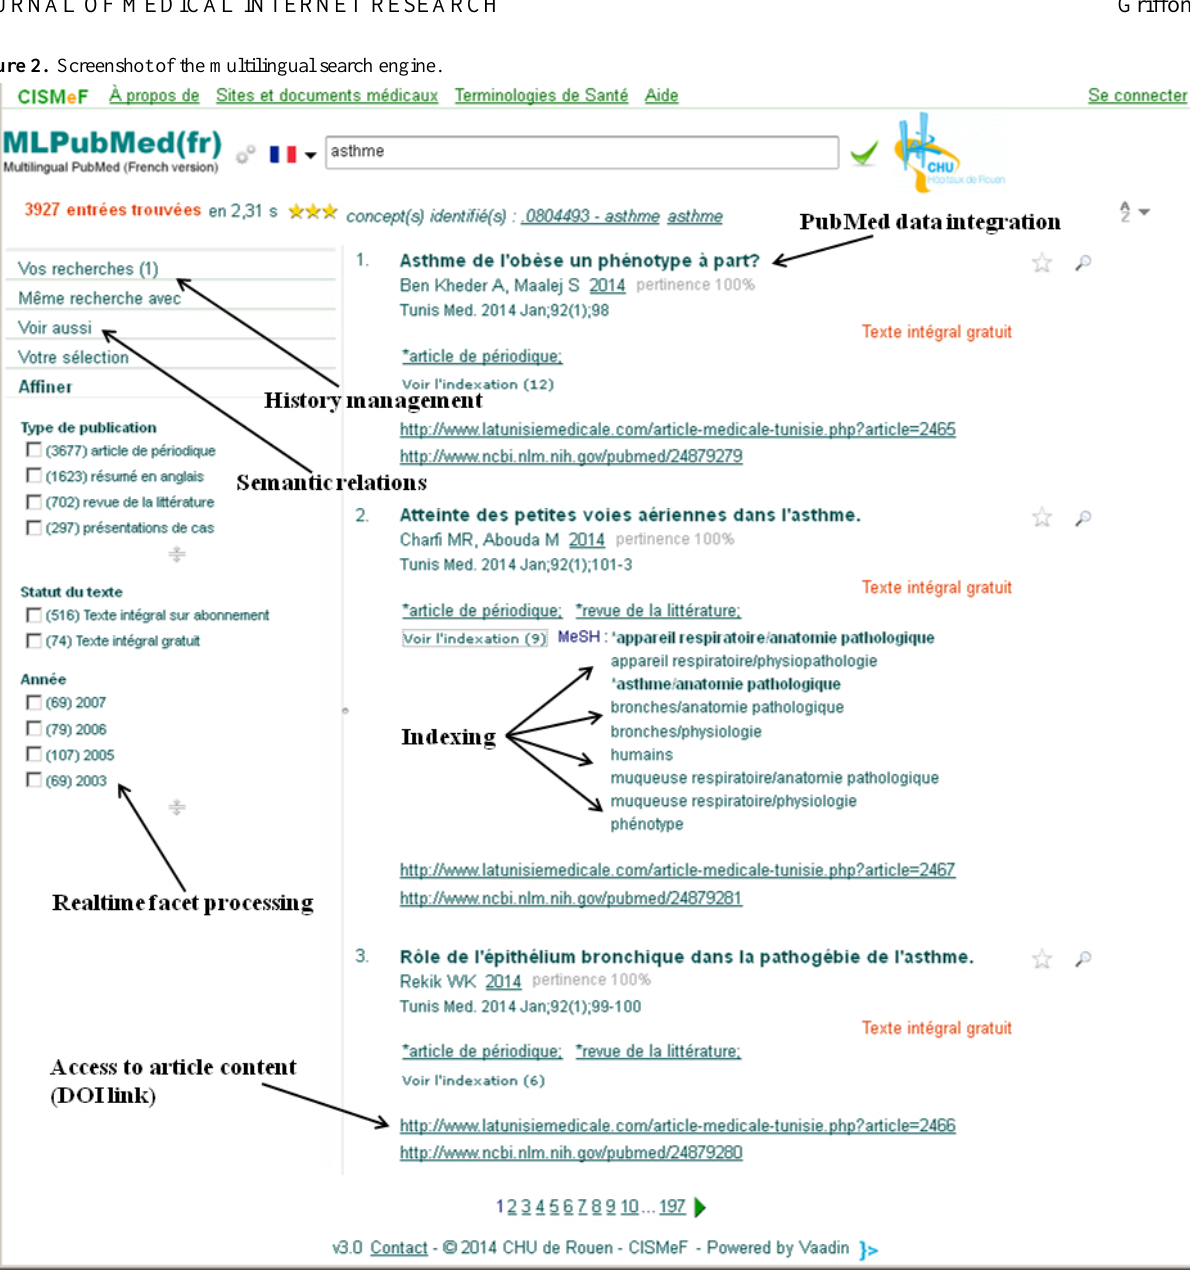
Figure 2. Screenshot of the multilingual search